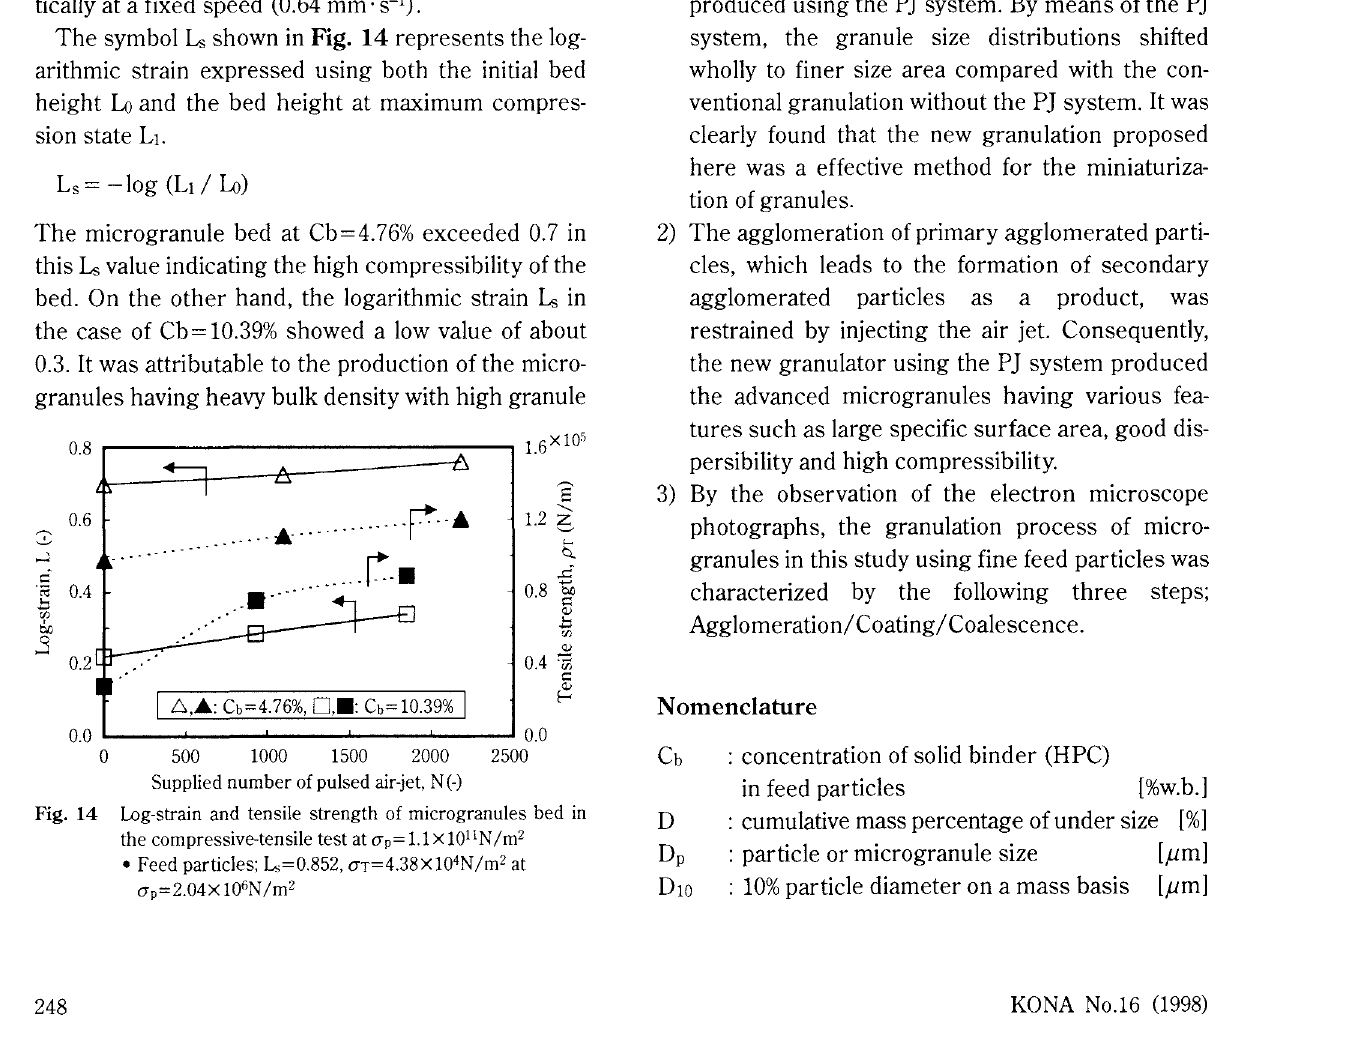
Fig. 14 Log-strain and tensile strength of microgranules bed in the compressive-tensile test at O"p= 1.1 x 10llN/m 2